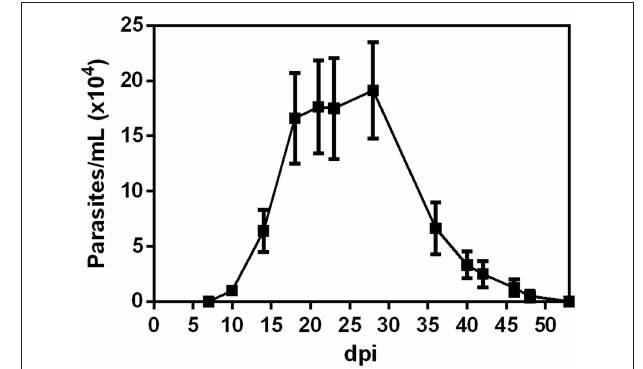
FIGURE 1 | Parasitemia development. Male BALB/c mice were infected with 5 × 10 4 insect-derived metacyclic forms of T. cruzi within the oral cavity. Parasitemia (mean and SEM) was assessed during the acute phase and is expressed as parasites per milliliter. Parasites were counted by light microscopy and parasitemia calculated by the Pizzi-Brener method. n: 7 dpi = 21, 10, and 14 dpi = 15, 18 dpi = 18, 21 dpi = 11, 23 dpi = 6, 28 dpi = 8; 36, 40, 42, 46, 48, and 53 = 4. The total number of animals in each time point was obtained from different